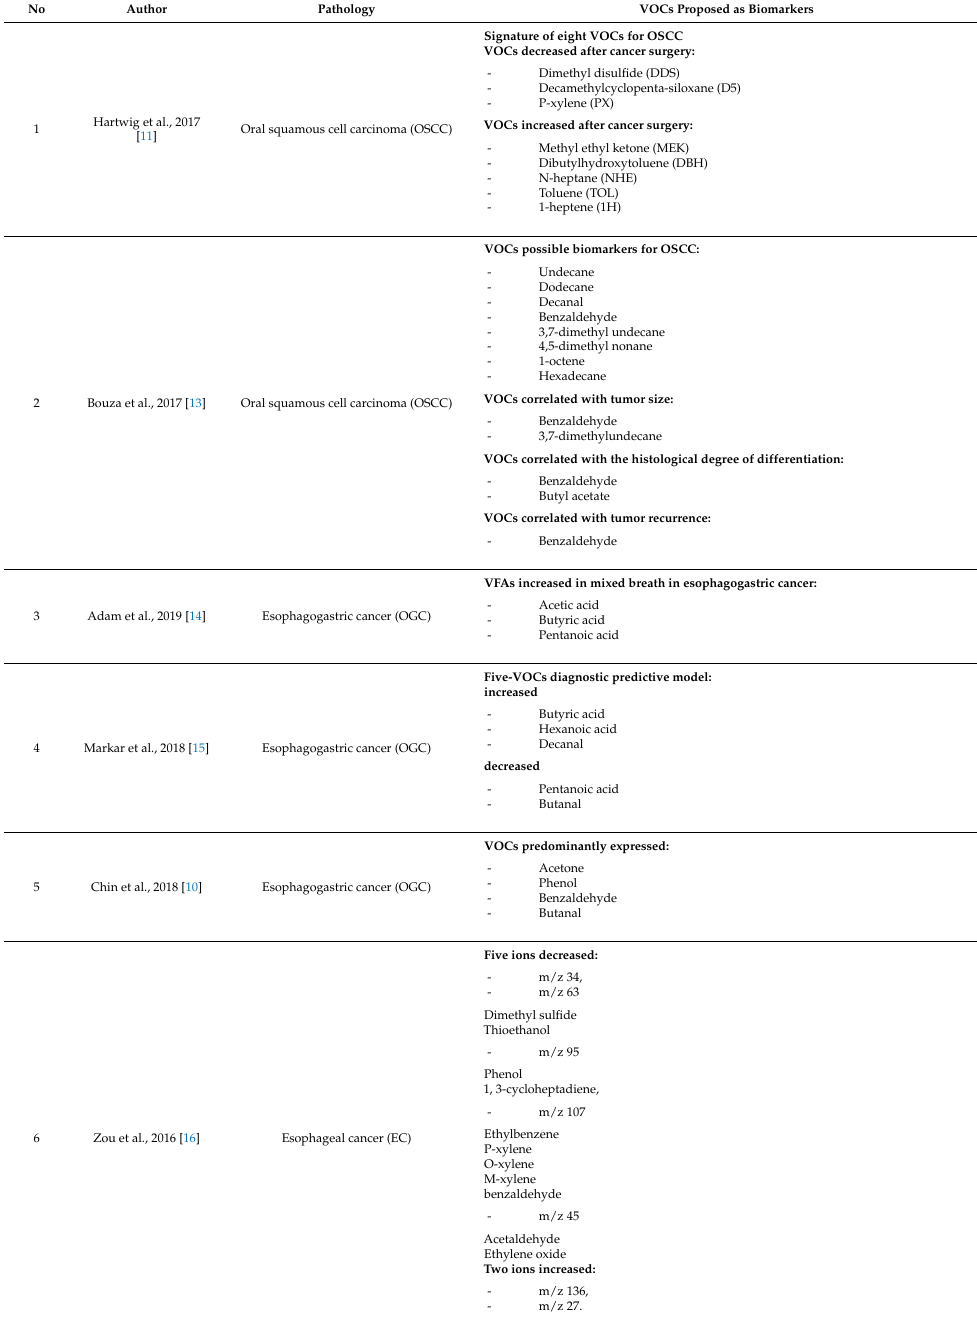
Table 1. Volatile organic compounds in digestive neoplasia: articles